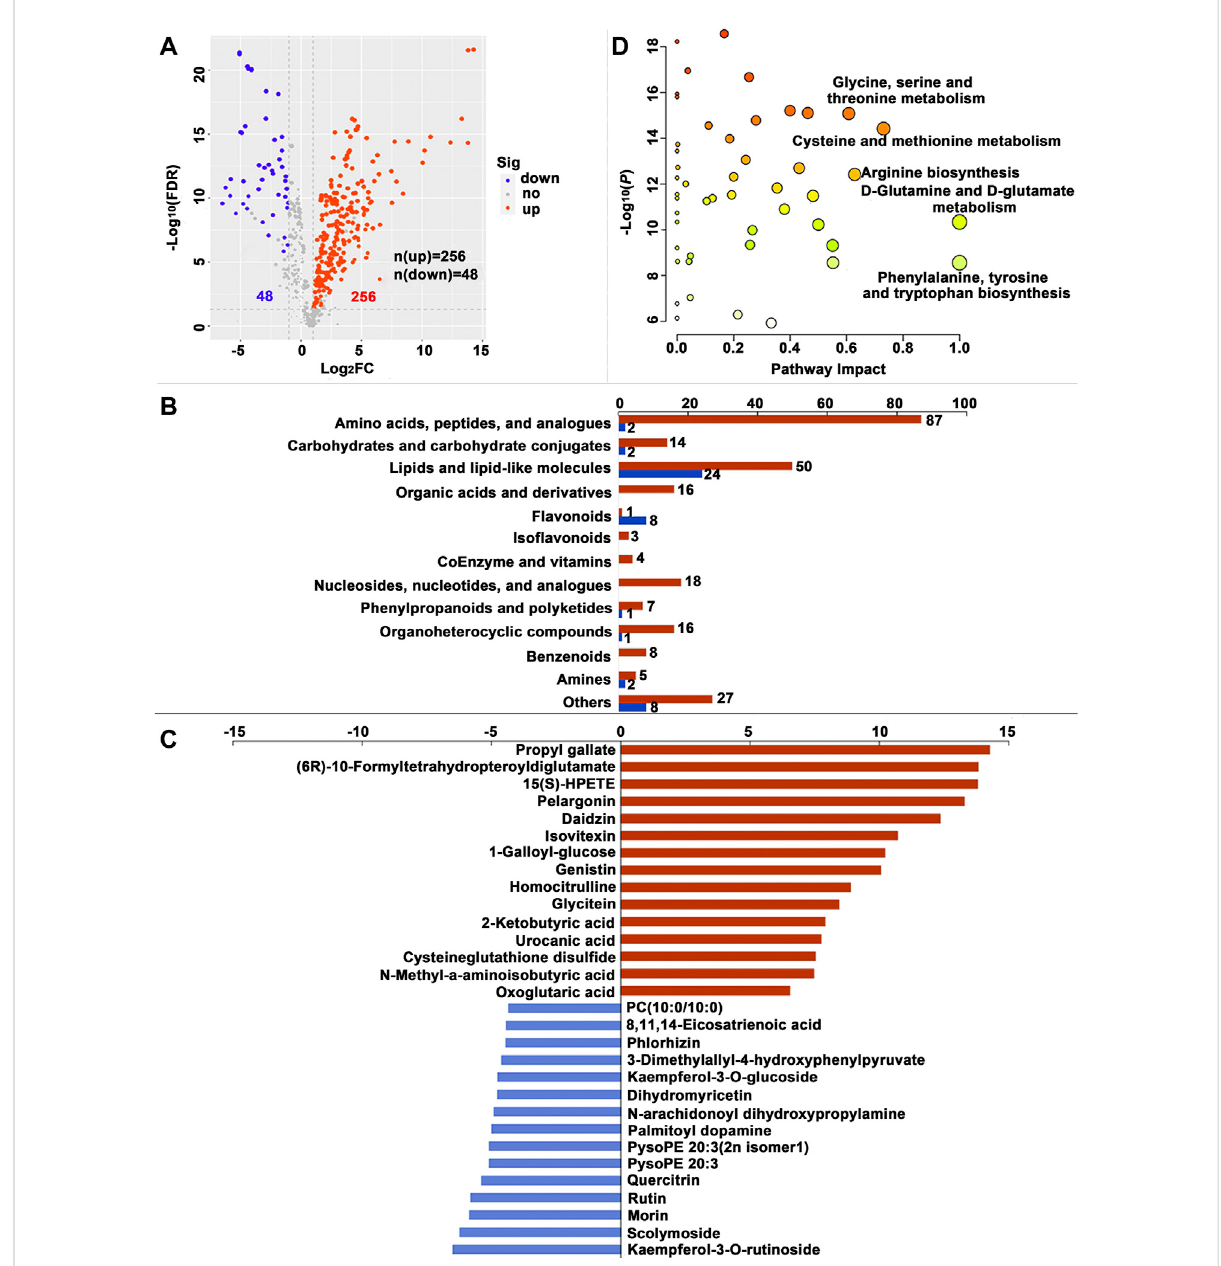
Signi fi cantly different metabolites (SDMs) and enriched pathways relating to different diets in the posterior silk gland (PSG). (A) Volcano plots of metabolites for the formula feed (FF) and the mulberryleaves (ML) silkworms in thePSG. The red dot represents the metabolite issigni fi cantly higher in the FF silkworms, and the blue dot indicates a higher abundant metabolite in the ML silkworms. The dot size represents the VIP value. (B) SDMs classi fi cation and variation between the FF and ML group. The blue and red bar indicate the number of downregulated and upregulated metabolites in the PSG of the FF group, respectively. (C) The top 15 upregulated SDMs and downregulated SDMs in the PSG of the FF silkworms. (D) Metabolic pathways enriched by the SDMs between the FF and ML groups in the